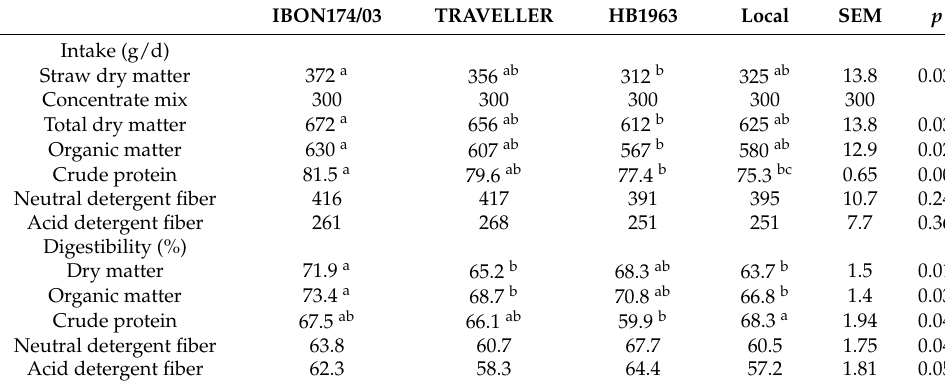
Table 3. Nutrient intake and nutrient digestibility coefficients in Horro lambs fed diets containing straw from different varieties of barley supplemented with a concentrate mixture.